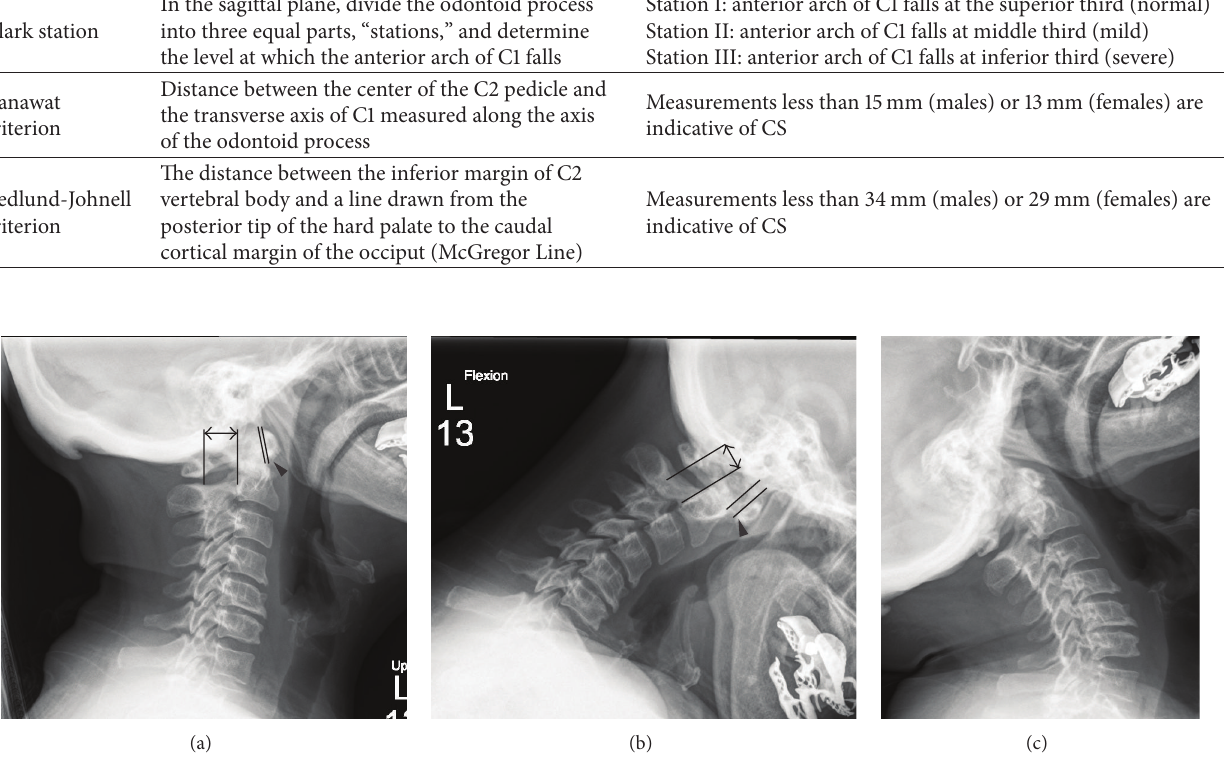
Figure 2: Lateral radiographs of a patient with atlantoaxial instability. In the neutral view the AADI ( arrowhead) is 1mm and the PADI ( double arrow) is 20 mm (a). In flexion the AADI increases to 7 mm and the PADI decreases to 13 mm (b). In extension the AADI and PADI reduce to their neutral measures (c).